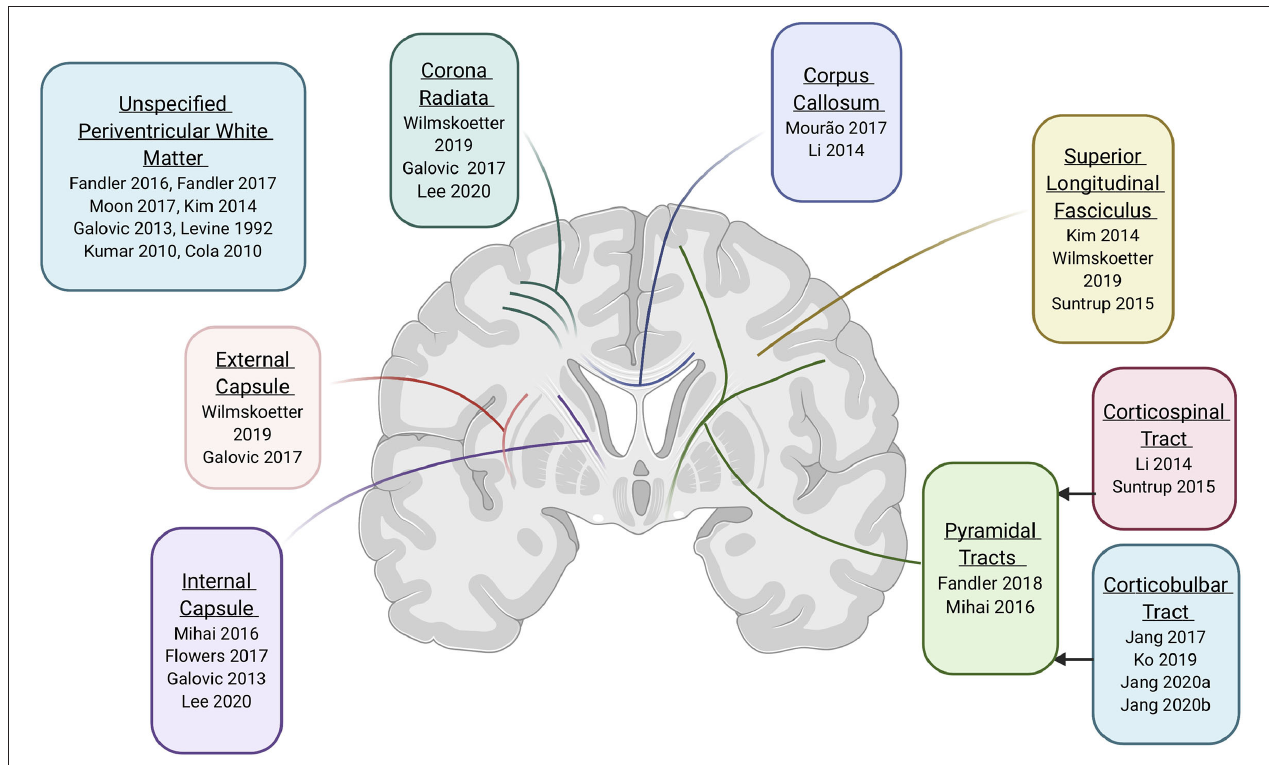
FIGURE 2 | Evidence for specific white matter tracts involved in neural control of swallowing (created with Biorender.com).